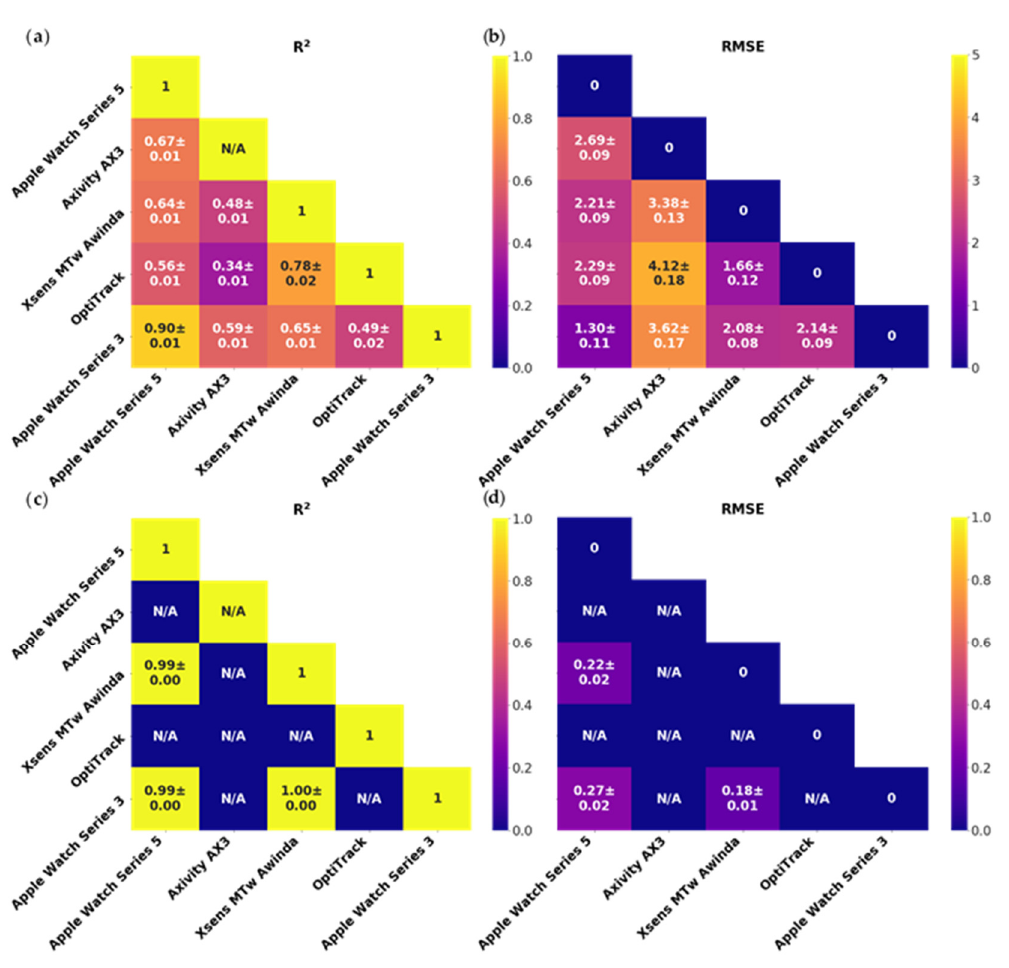
Figure 5. Triangle diagrams of the sensor validation study aggregated by pairwise signal measures (R 2 for dynamic tracking of signals and RMSE metrics for offsets) between the selected motion sensors (Apple Watch Series 3 and 5, Xsens, Axivity, and Optitrack). Data is organised in ( a ) linear acceleration R 2 , ( b ) linear acceleration RMSE (m · s − 2 ), ( c ) angular velocity R 2 , and ( d ) angular velocity